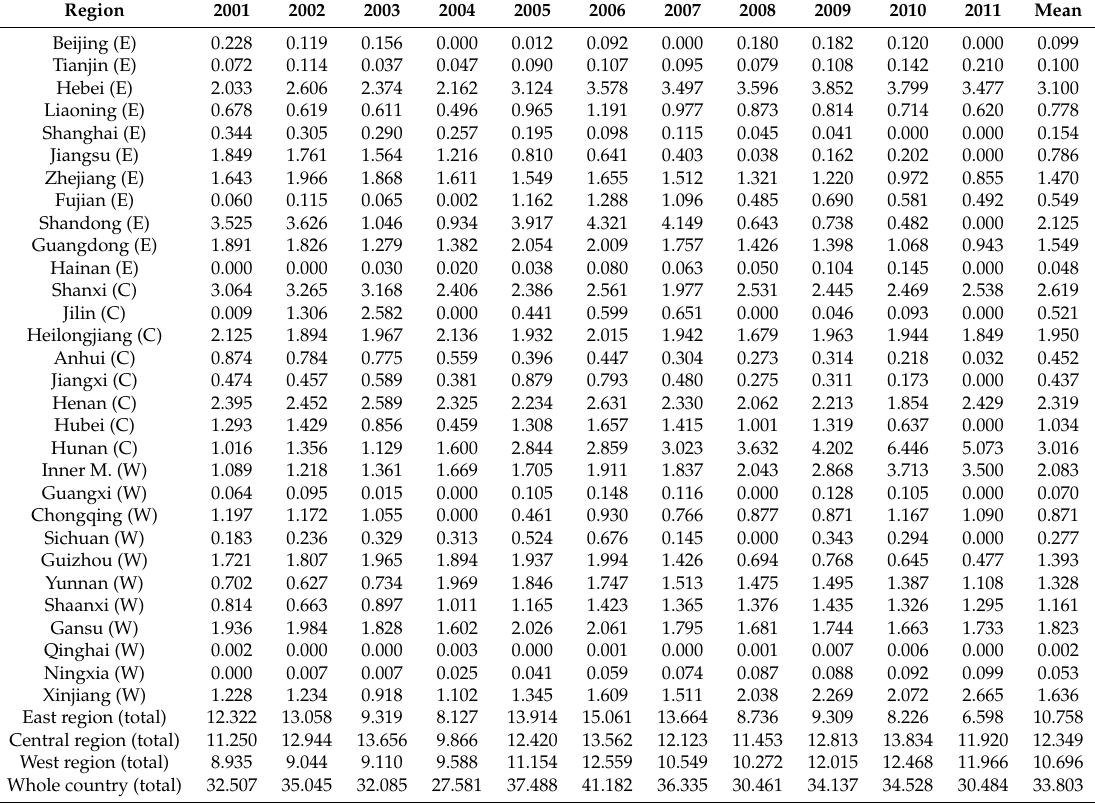
Table 4. Energy savings potential for each province from 2001 to 2011